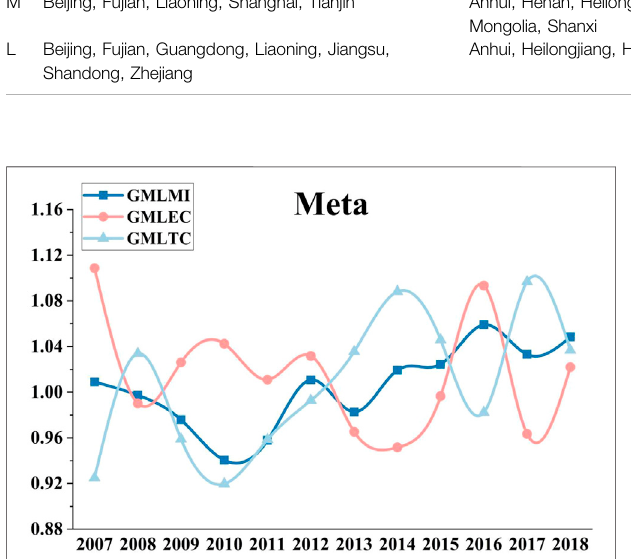
FIGURE 4 | GMLMI and its decomposition index under meta Frontier surface from 2007 to 2018.